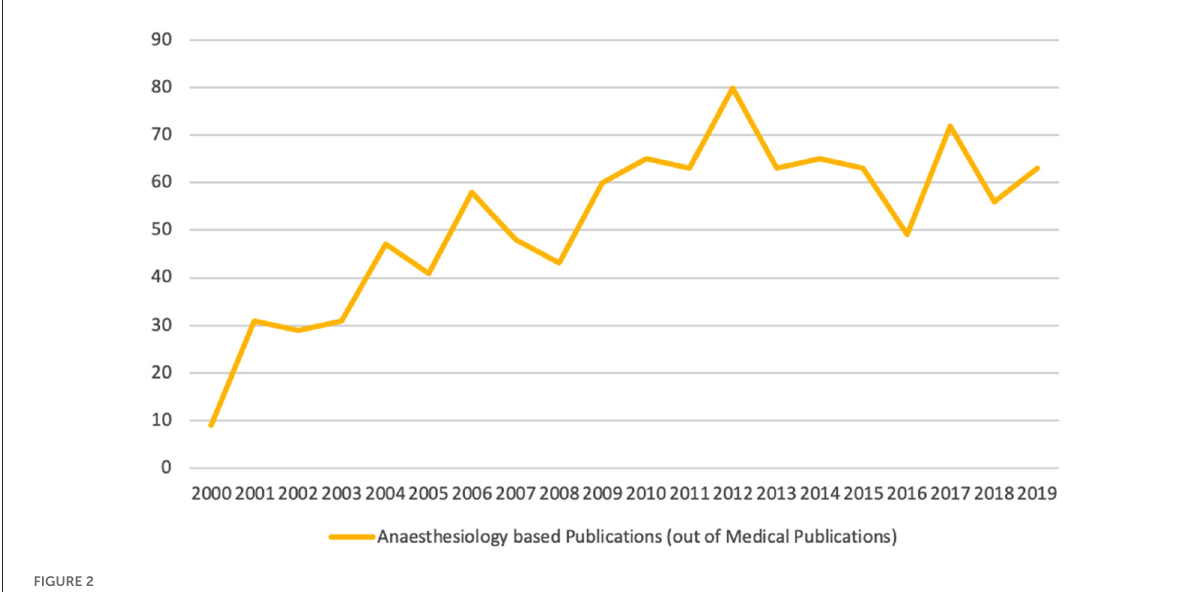
FIGURE2 Number of anesthetic publications per year citing To Err Is